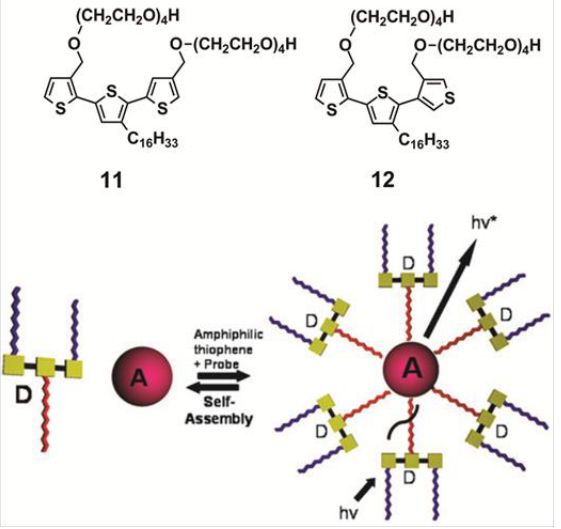
Scheme 4. Molecular structures of 11 and 12 and schematic representation of the ET-system that is formed from the donor (D) thiophene amphiphiles ( 11 and 12 ) and the hydrophobic acceptor (A). Reproduced with permission from [32]. Copyright 2009 The Royal Society of